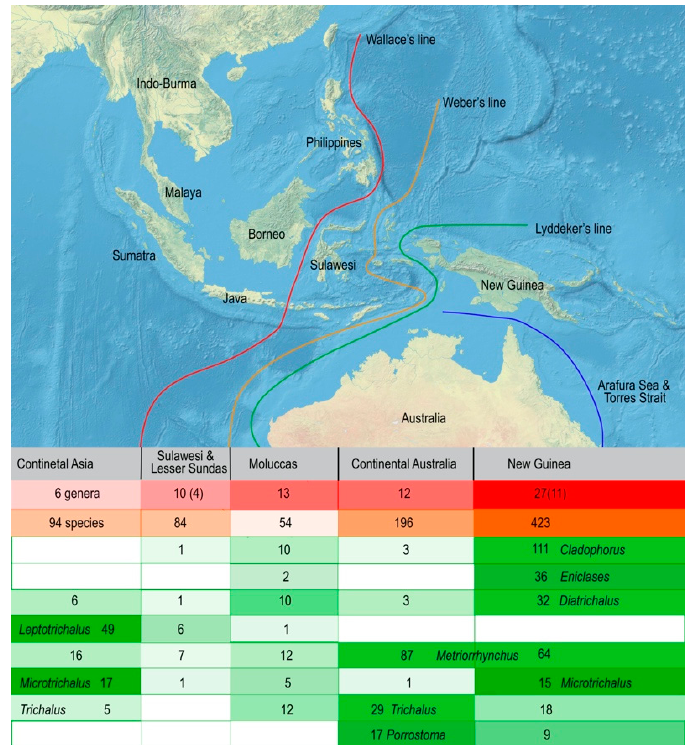
Figure 8. Overview of the dispersal barriers in continental Asia, Malesia, and Australia with the distribution summary of certain Metriorrhynchina genera. Almost all species occur only in a single area; only a single species has been reported from the regions separated by a zoogeographical line ( M. thoracicus ; Bocak & Matsuda 1998); however, the record from the Moluccas has never been confirmed, and it is possibly based on a mislabeled specimens used for the description of M. cyaniventris (Redtenbacher, 1867). The numbers of genera in parentheses refer to those endemic to the region.